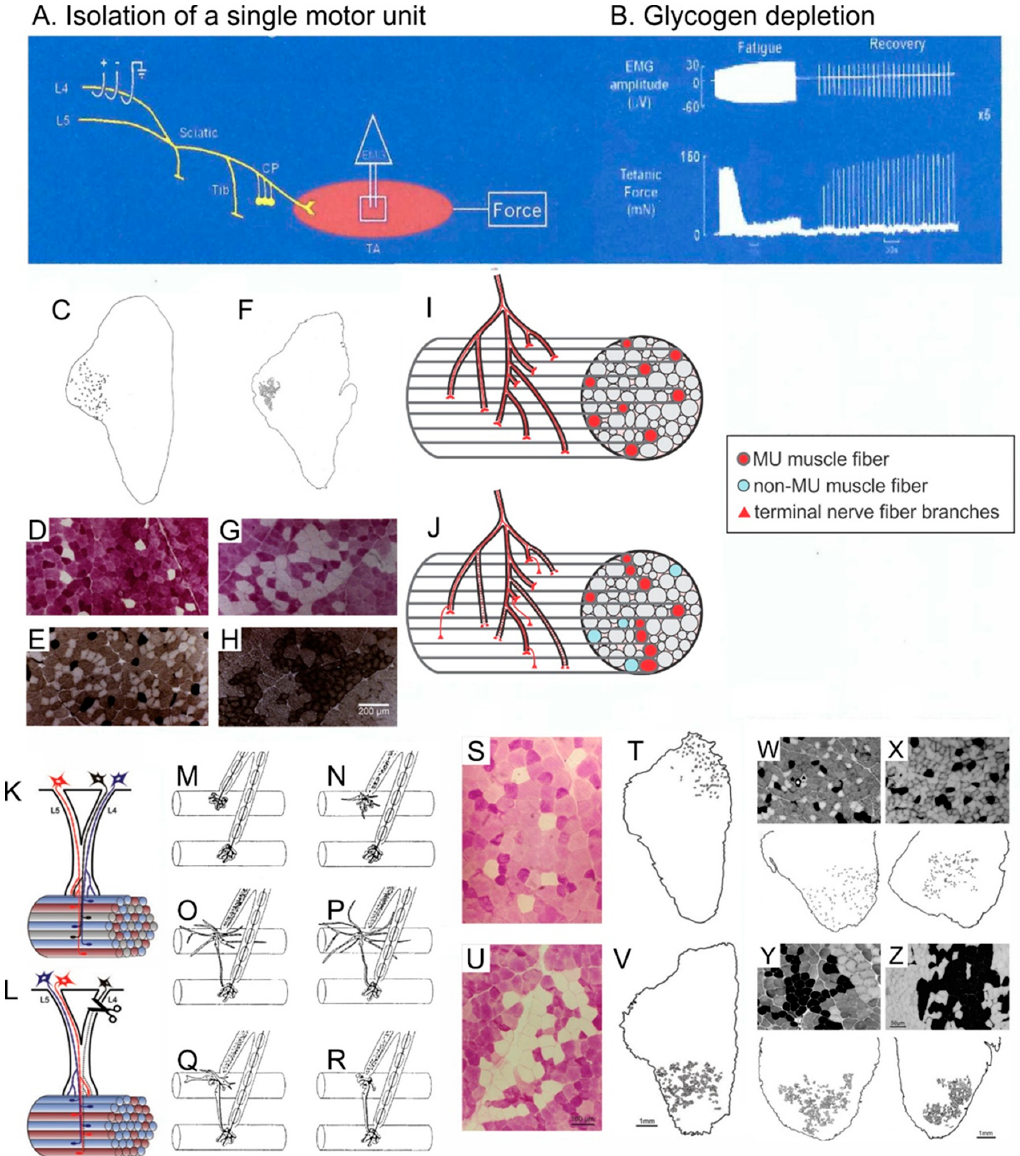
Figure 6. The motor unit (MU) spatial territory that contains all the muscle fibers innervated by one motoneuron, limits the numbers of muscle fibers that each reinnervating nerve can reinnervate after complete and partial nerve injuries. Muscle force was recorded from isolated MUs in tibialis anterior (TA) muscle by all-or-none electrical stimulation of dissected ventral root filaments after a laminectomy to expose the lumbosacral spinal cord ( A ). The MU muscle fibers were depleted of their glycogen by repetitive stimulation at 1 and 5 Hz to fatigue the MU fibers followed by recovery during 0.1 Hz stimulation This sequence was repeated until the MU force failed to recover ( B ). The TA muscle was dissected rapidly. The muscle was frozen for cryosectioning and staining for glycogen with Periodic Schiff reaction to reveal and count glycogen depleted MU fibers in normally innervated ( C , D ) and reinnervated ( F , G ) TA muscle fibers after common peroneal (CP) nerve section and surgical repair and for histochemical staining of acidic mATPase to fiber type the MU muscle fibers ( E , H ). The MU muscle fibers are normally distributed in a mosaic pattern ( C – E ) which changes to F, G, H. clumping of the fibers that occupy a smaller territory ( F – H ). The branching pattern of the motor nerve is shown in normally innervated ( I ) and reinnervated ( J ) MUs. In normally innervated muscles, each motor nerve normally branches only once the nerve enters the muscle. Thereafter, the nerve branches to